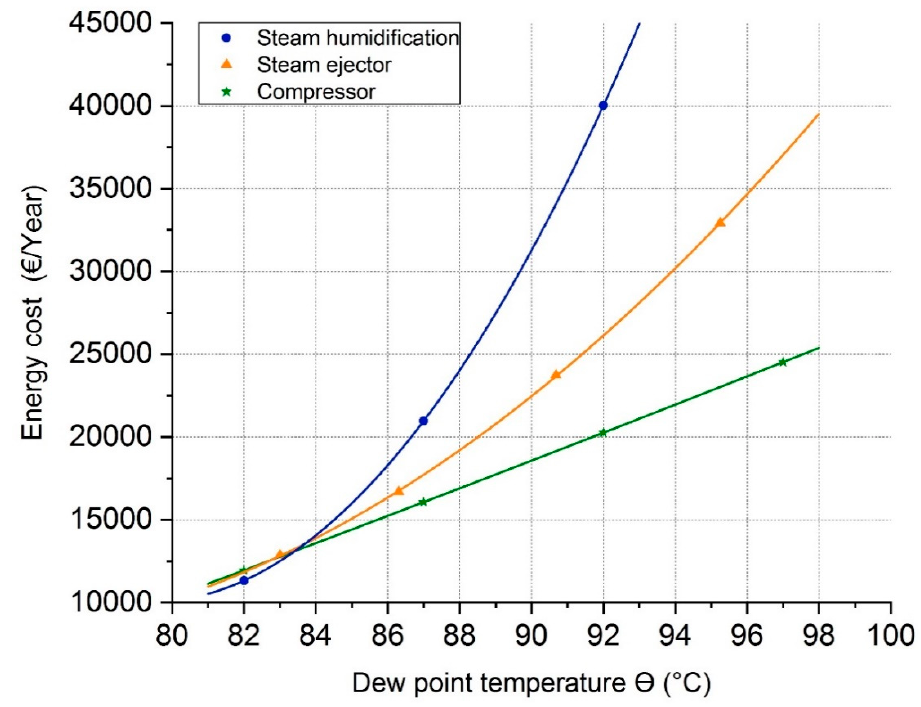
Figure 10. Estimated energy costs for the investigated concepts.